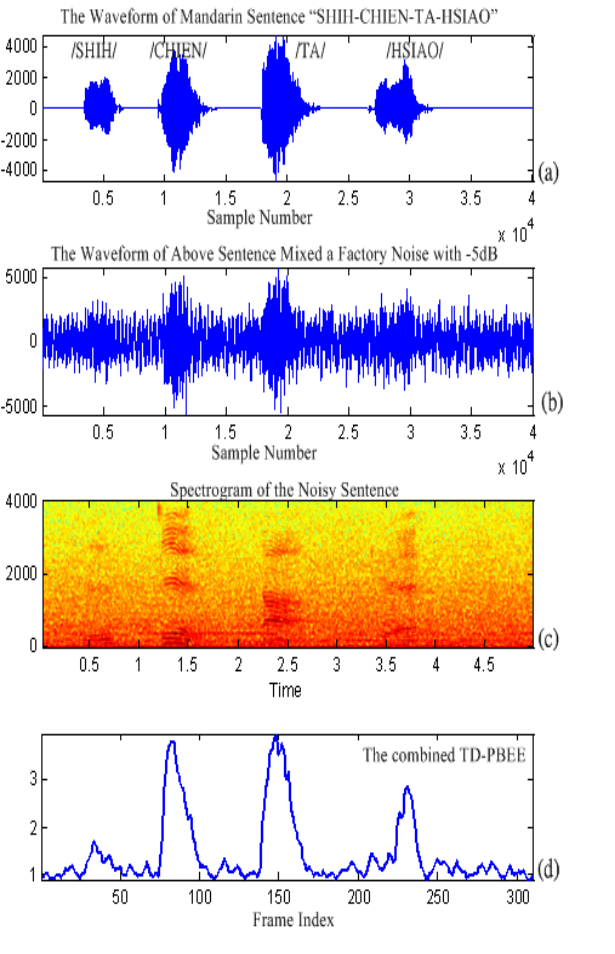
Figure 8. The development of the combined TD-PBEE feature